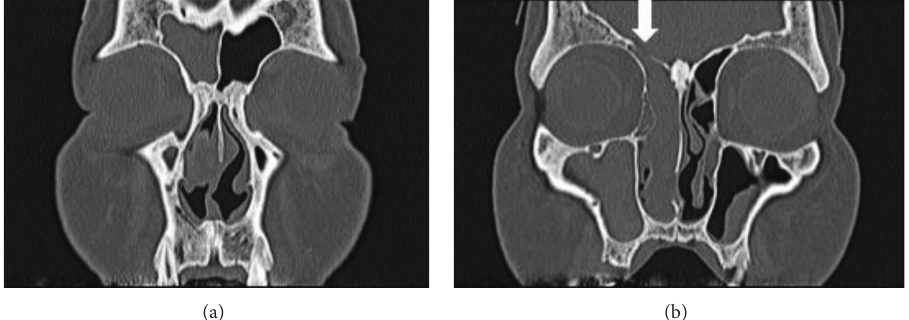
Figure 2: CT showed an isodense mass which occupied the right nasal cavity, maxillary, ethmoid, and frontal sinuses, with no erosion of the bony walls. ↓ : A small defect in the cribriform plate.